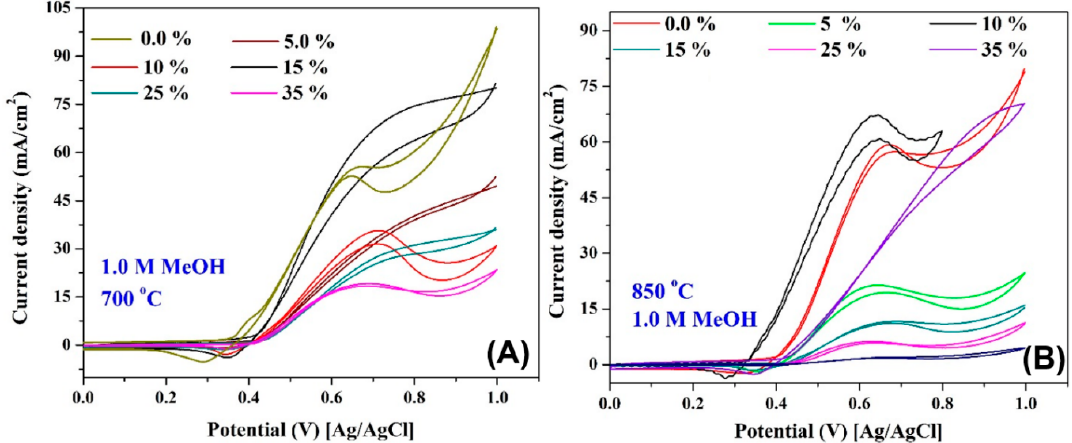
Figure 9. Electrocatalytic activity of Ni/C nanofibers containing different Sn contents and prepared at 700 °C ( A ) and 850 °C ( B ) toward methanol oxidation (1.0 M in 1.0 KOH) at room temperature and at a scan rate of 50 mV/s.